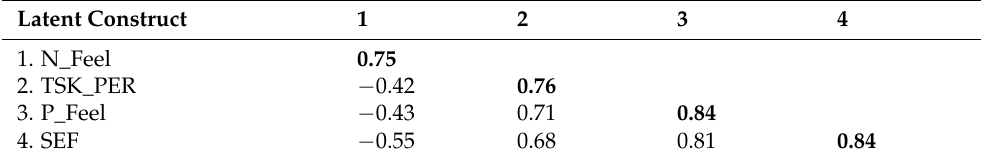
Table 5. Discriminant validity with Fornell-Larker criterion